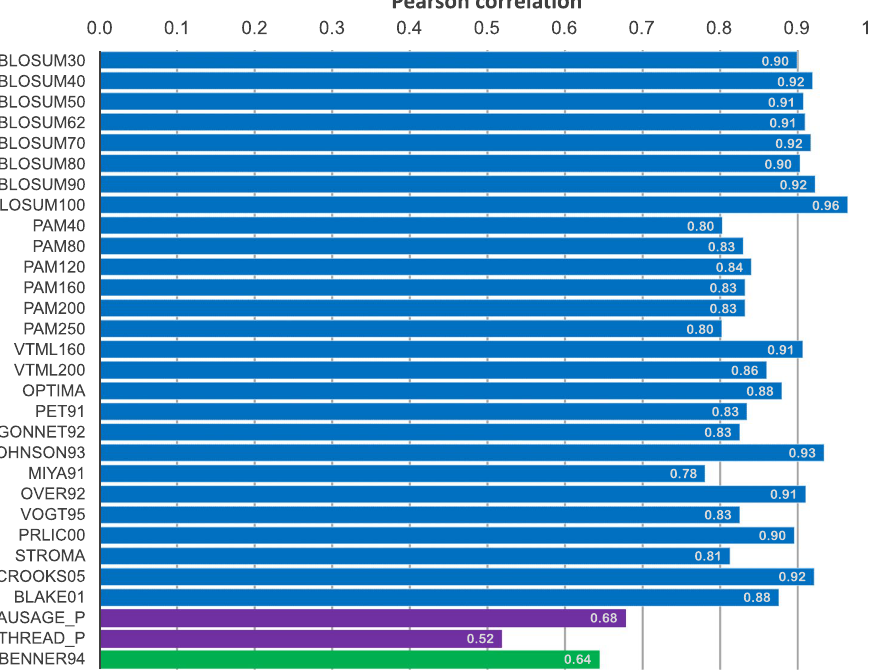
Figure 5. Pearson correlation coefficients between the replacement inertia I X (Table 1) and the mutability of thirty replacement matrices. Alignment derived matrices are shown in blue, force field derived matrices in purple, and the genetic code derived matrix in green. See Supplementary Table S1 for the